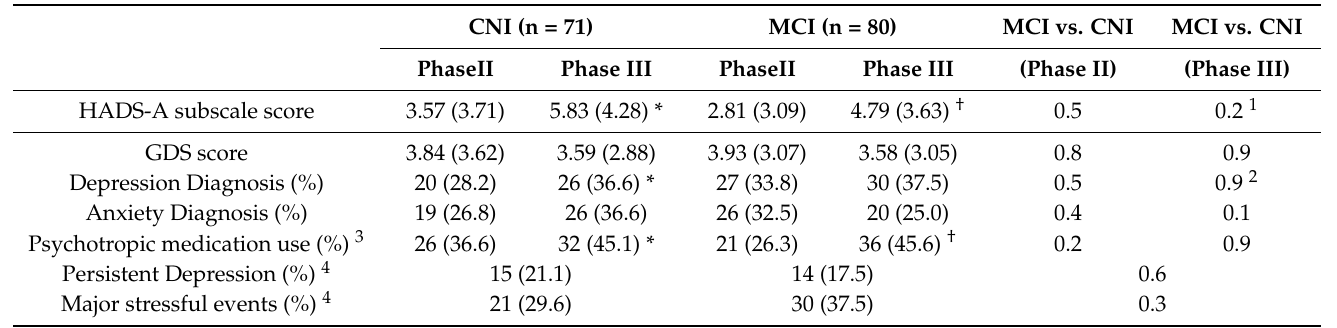
Table 2. Mental health characteristics assessed in Phase II and III for cognitively non-impaired (CNI) and MCI participants (according to Phase II